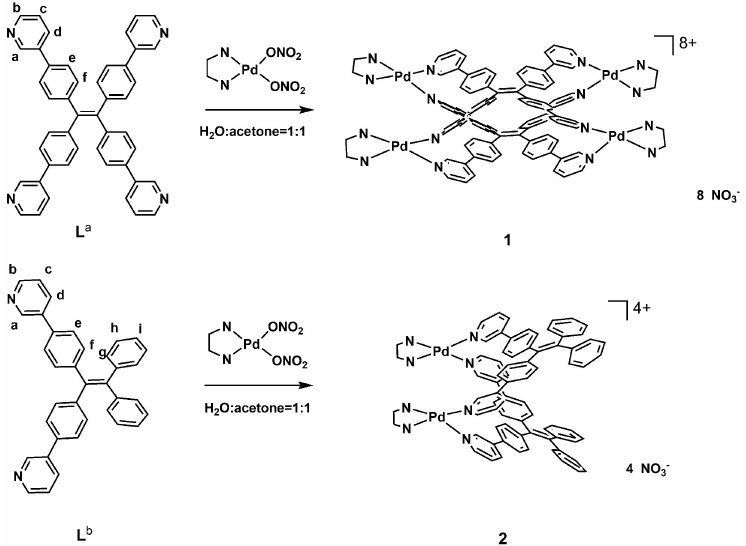
Scheme 1. Coordination-driven self-assembly of supramolecular complexes 1 and 2 from two TPE-based ligands L a,b and the cis -blocked (en)Pd(NO 3 ) 2